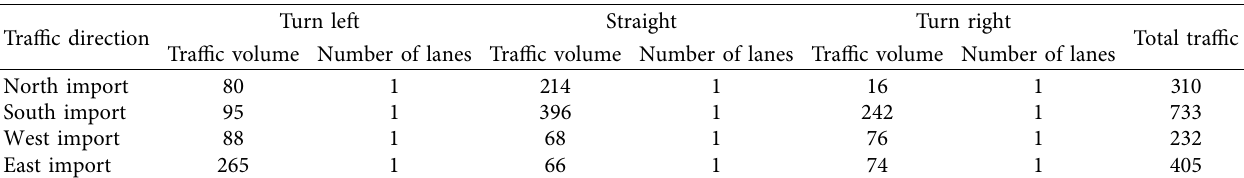
Table 2: Traffic statistics.